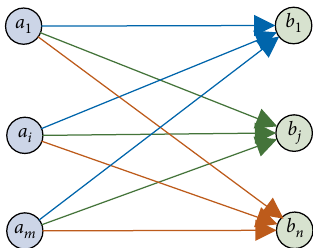
Figure 2: Schematic to a general connection between upstream and downstream